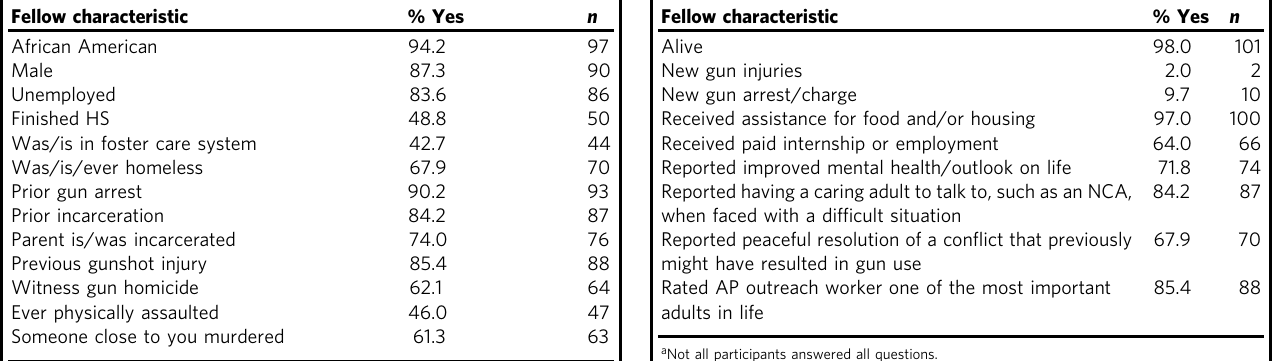
Table 1 Advance Peace Sacramento, fellow participant pro fi les at intake a .